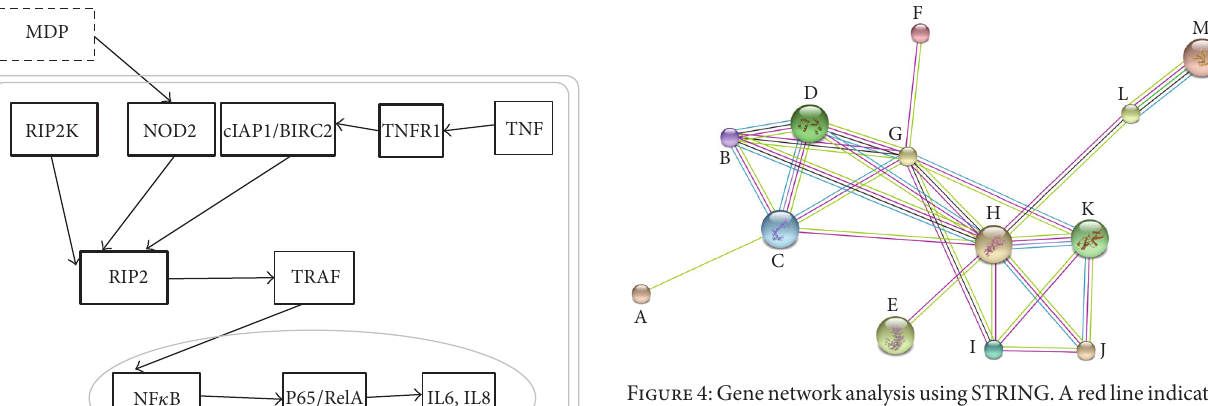
Figure4:GenenetworkanalysisusingSTRING.Aredlineindicates the presence of fusion evidence; a green line indicates neighborhood evidence; a blue line indicates cooccurrence evidence; a purple line indicates experimental evidence; a yellow line indicates text-mining evidence; a light blue line indicates database evidence; a black line indicates coexpression evidence. Gene identification: A: Farnesyl diphosphate farnesyltransferase; B: Twitchin-like; C: Calmodulin; D: Myosin light chain; E: K14280 Exportin-like; F: PolyBC binding protein-like; G: Myosin heavy chain; H: Actin-related protein 1; I: Microtubule-associated monooxygenase- calponin- and LIM- domain-containing protein; J: Actin-related protein 2/3 ( Arp 2/3 ); K: Actin-related protein 2a-like; L: Elongation factor-2-like; M: 40S ribosomal protein